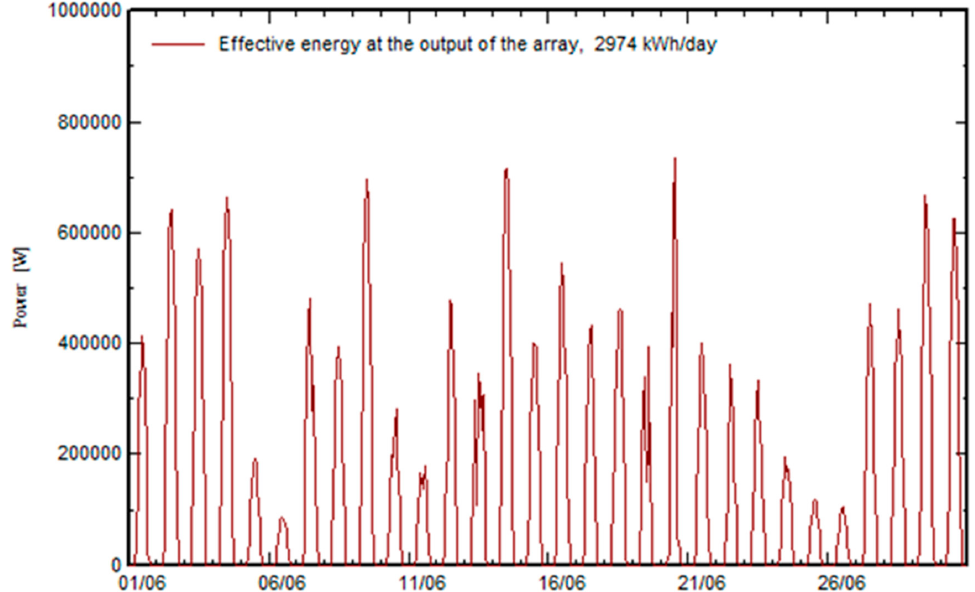
Figure 6. Energy injected into the grid in the month of June.